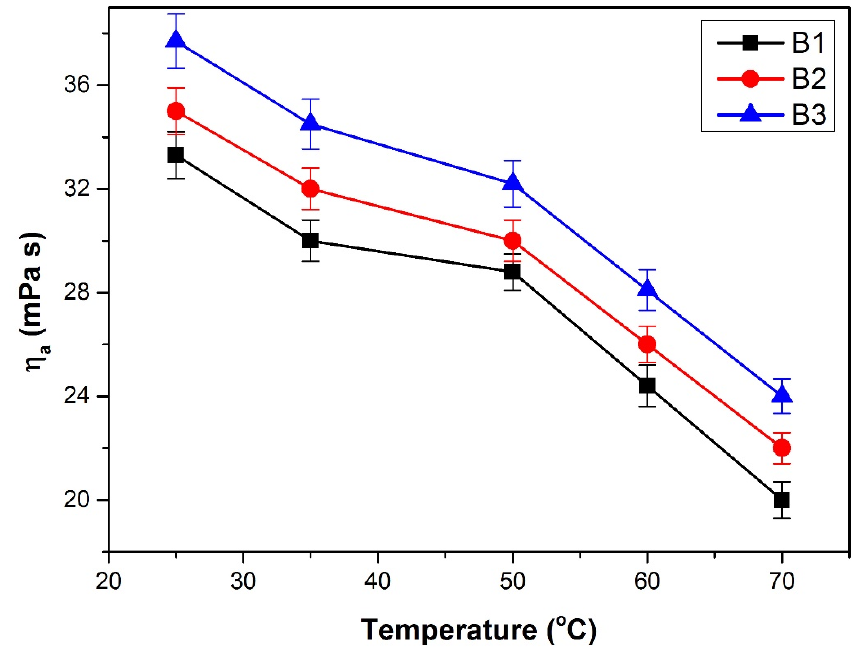
Figure 9. The dependence of the apparent viscosity on temperature for bioesters (B1–B3).